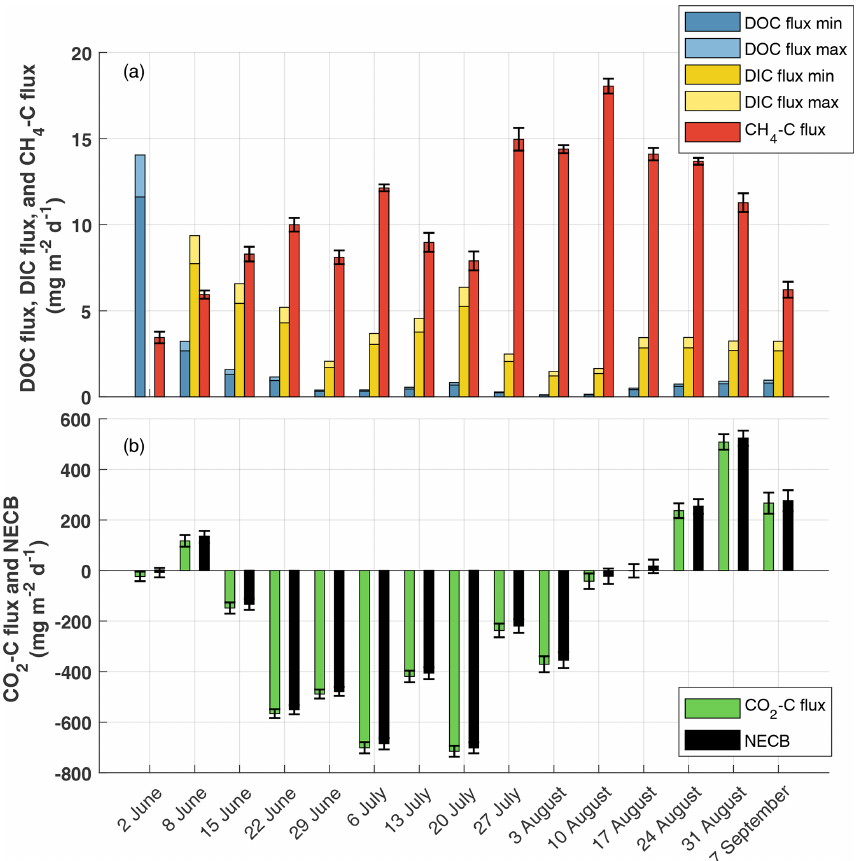
Figure 4. Seasonal development of NECB components as mean daily fluxes from 2 June (week 1) to 8 September (week 15). (a) Minor components of NECB: DOC flux (blue), DIC flux (yellow), and CH 4 -C flux (red); (b) Major component of NECB: CO 2 -C flux (green) and the resulting NECB (black). Please note the different values of the y axis in (a) and (b) . Uncertainties from systematic errors are denoted with a second bar in a brighter color, while uncertainties from random errors are indicated with an error bar. The systematic uncertainty in the NECB is shown but not visible due to its small